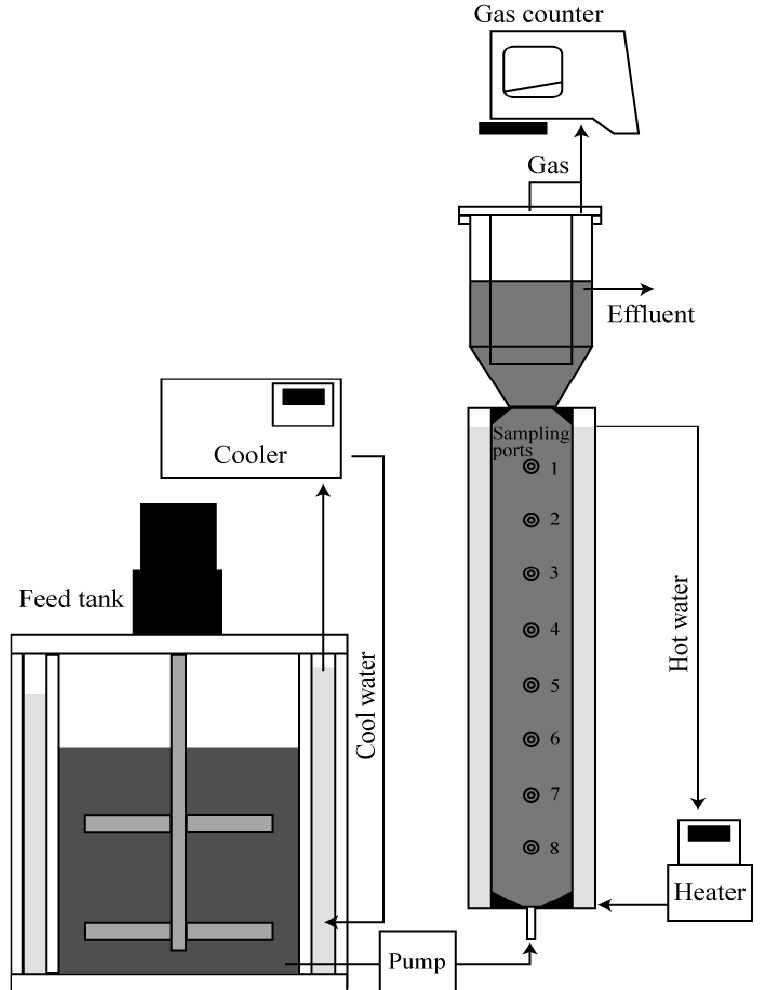
Figure 1. The schematic of the experimental